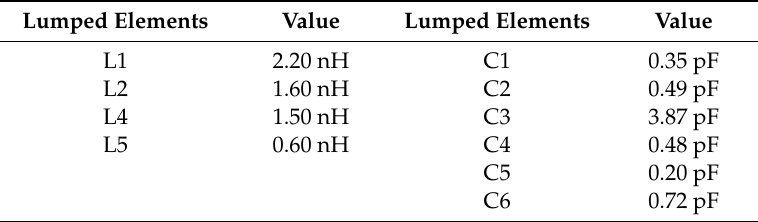
Table 2. The ideal lossless elements values of the proposed modified Chebyshev